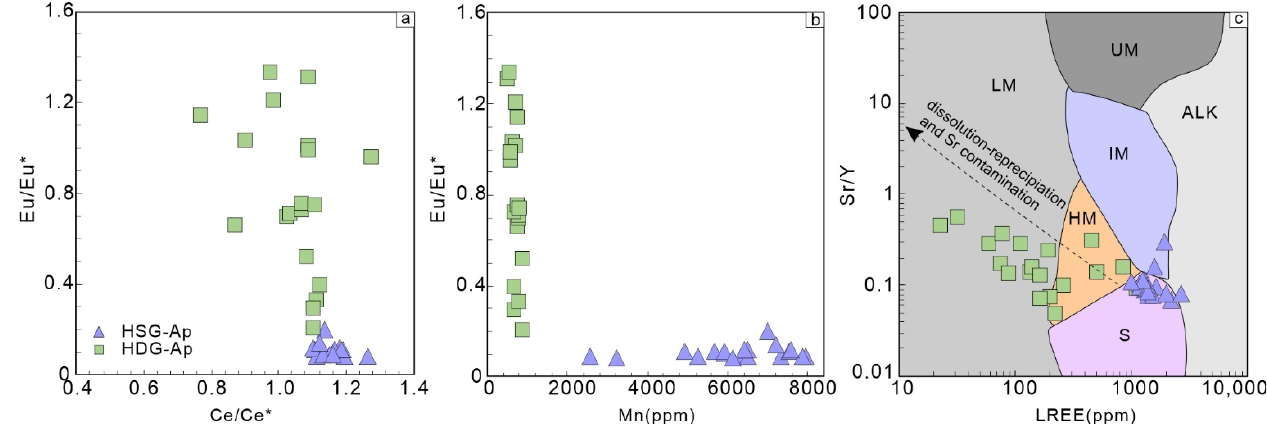
Figure 10. Biplots of apatite from the bedrock apatite database. ( a ) Eu/Eu* vs. Ce/Ce* in apatite. ( b ) Eu/Eu* vs. Mn contents in apatite. ( c ) Sr/Y vs. Σ LREE (defined here as La-Nd), modified from O’Sullivan et al. [109]. Abbreviations for groups: ALK—alkali-rich igneous rocks; IM—mafic I-type granitoids and mafic igneous rocks; LM—low- and medium-grade metamorphic and metaso- matic; HM—partial-melts/leucosomes/high-grade metamorphism; S—S-type granitoids and high aluminum saturation index (ASI) ‘felsic’ I-types; UM—ultramafic rocks including carbonatites, lher- zolites, and pyroxenites.